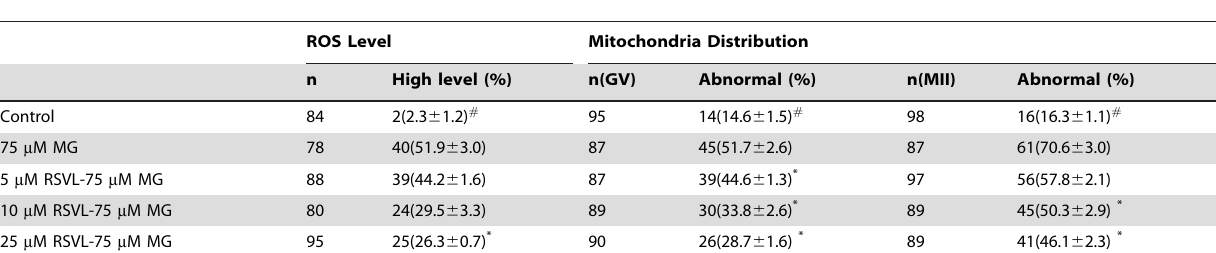
Table 1. Effect of methylglyoxal and resveratrol on the ROS level and mitochondria distribution of oocytes.